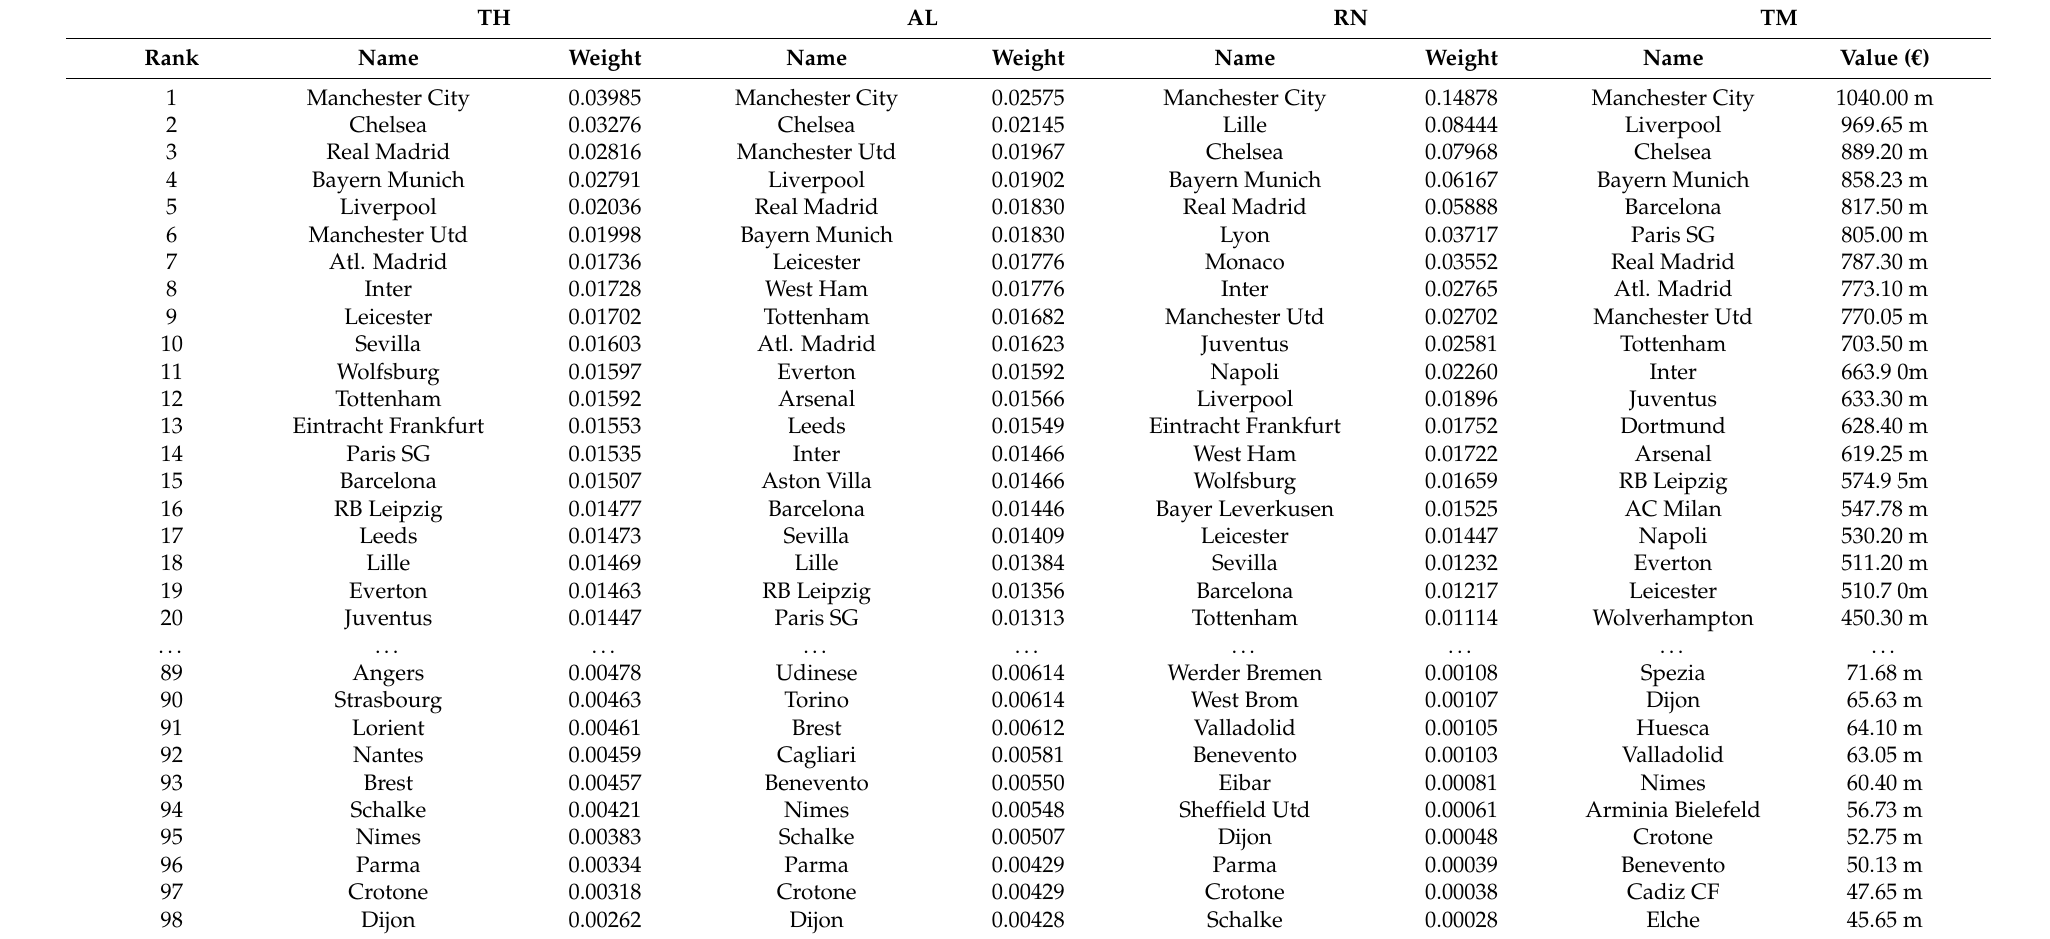
Table 4. Rankings after aggregation, taking into account the international matches with W = 4